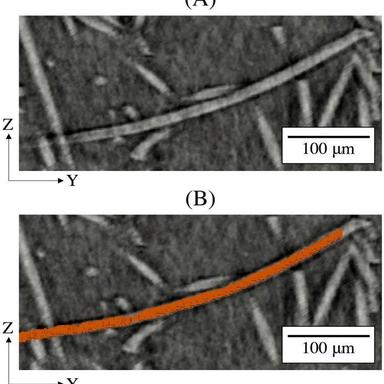
Comparison of the weight fiber length distributions determined nondestructively and destructively.